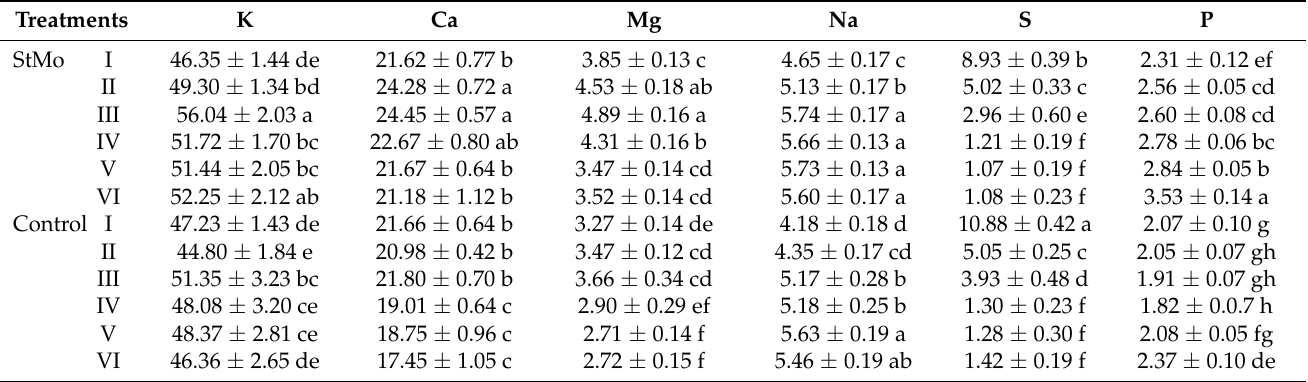
Table 6. Interaction biostimulant × harvest (B × H) on the average mineral content of rocket (g kg − 1 dw) . Different letters within each column indicate significant differences according at p = 0.05 (Tukey’s